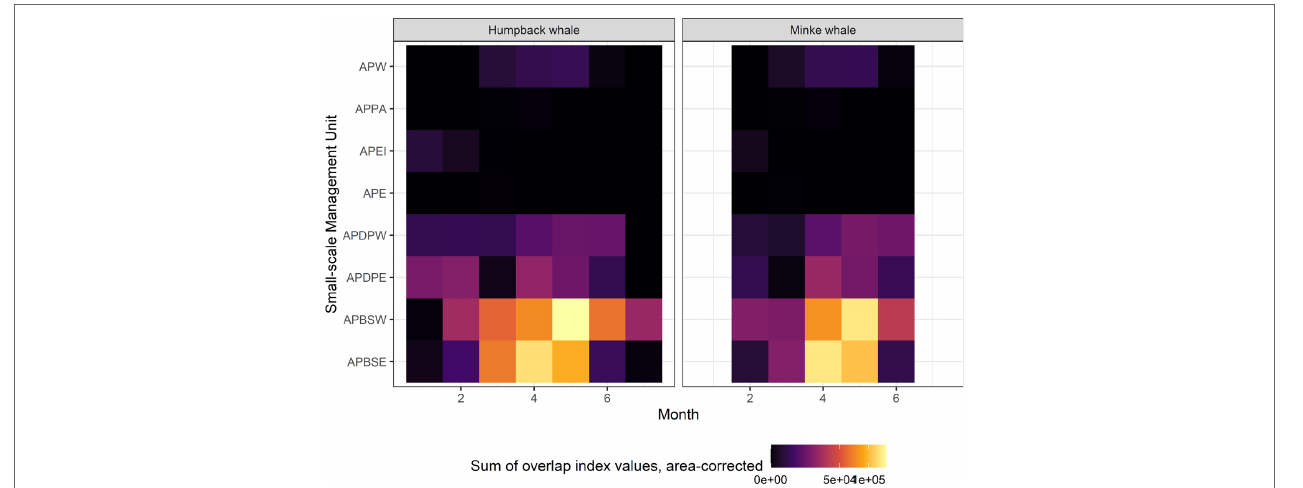
FIGURE 8 | Heatmap of the summed fishing-whale overlap index values (mapped in Figure 7 ) in each Small-Scale Management Unit (vertical axes), by month (horizontal axes). The summed values were divided by the number of grid cells in each Small-Scale Management Unit, to correct for size differences. APW, Antarctic Peninsula West; APPA, Antarctic Peninsula Pelagic Area; APEI, Antarctic Peninsula Elephant Island, APE, Antarctic Peninsula East; APDPW, Antarctic Peninsula Drake Passage West; APDPE, Antarctic Peninsula Drake Passage East; APBSW, Antarctic Peninsula Bransfield Strait West; APBSE, Antarctic Peninsula Bransfield Strait East.